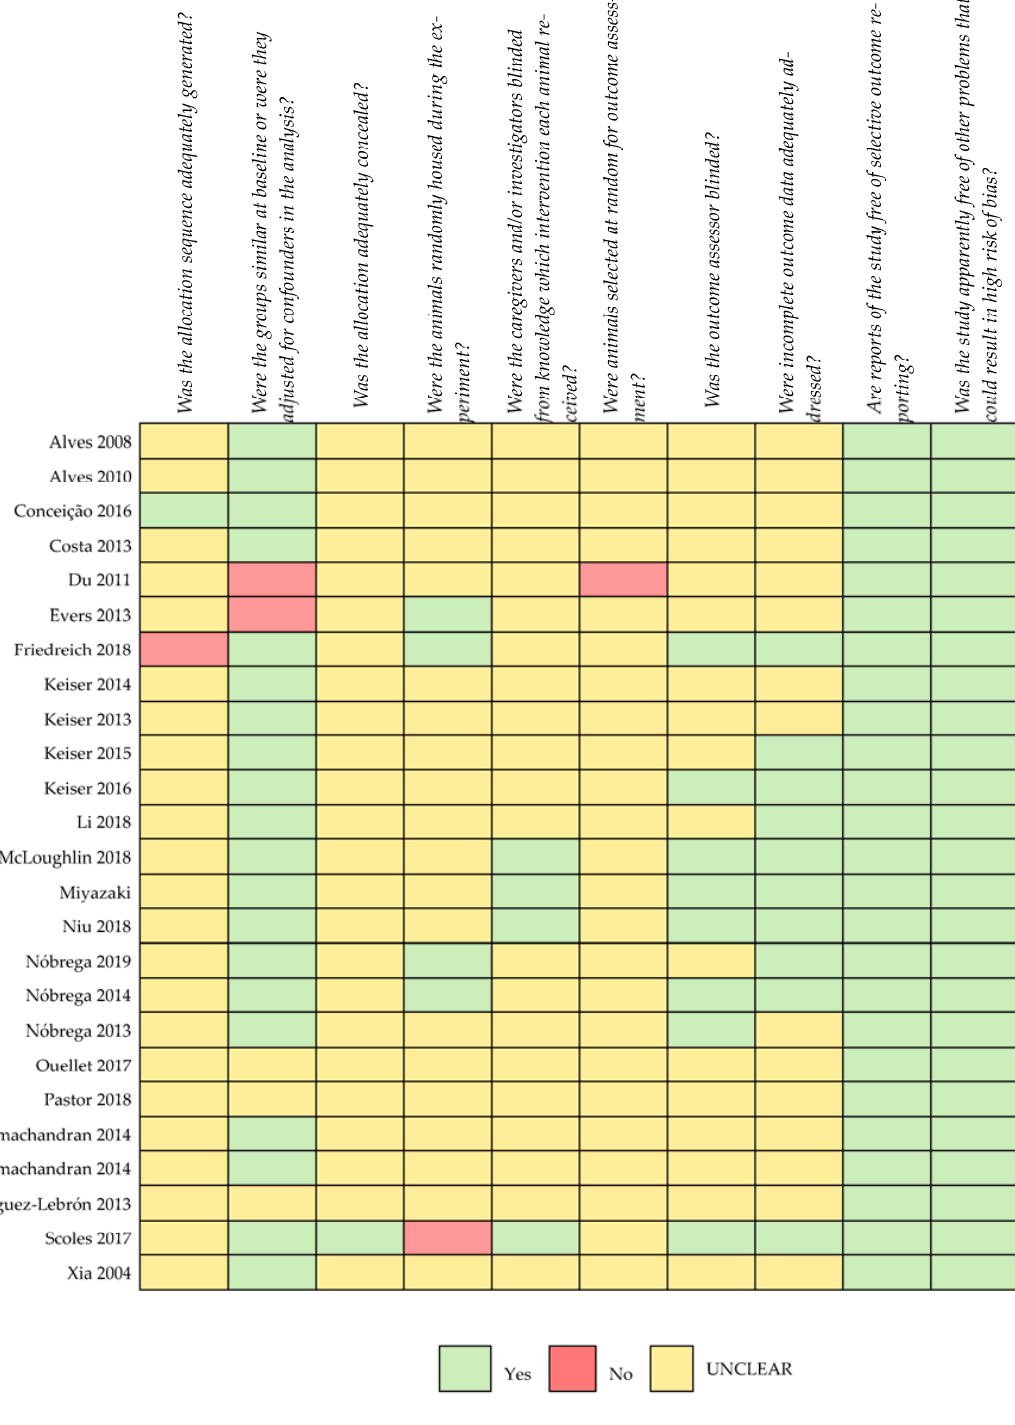
Figure 2. Risk-of-bias assessment (adapted from SCYRCLE’s risk-of-bias tool) [17–40]. The results were divided into four main categories: suppression efficacy, neuropathol- ogy, motor behaviour and safety profile. For each category, the selected papers used Eleven articles on Machado–Joseph disease (MJD)/spinocerebellar ataxia type 3